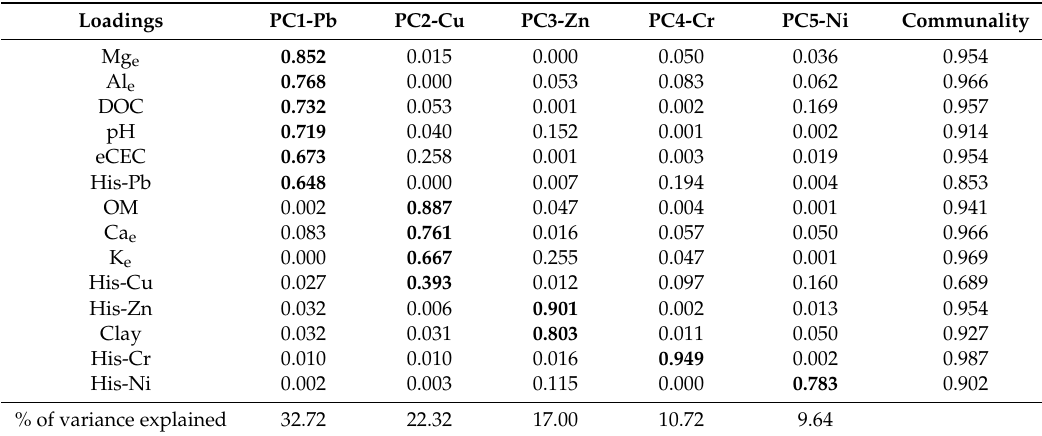
Table 4. Factor loadings of the soil properties in each principal component extracted. The loading of the component with the highest value for each soil property is in bold.